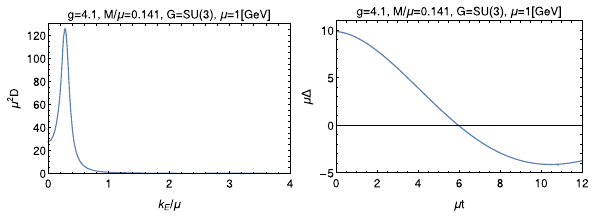
ratio min 0 < t < ∞ (cid:6)( t )/(cid:6)( t = 0 ) must be negative.